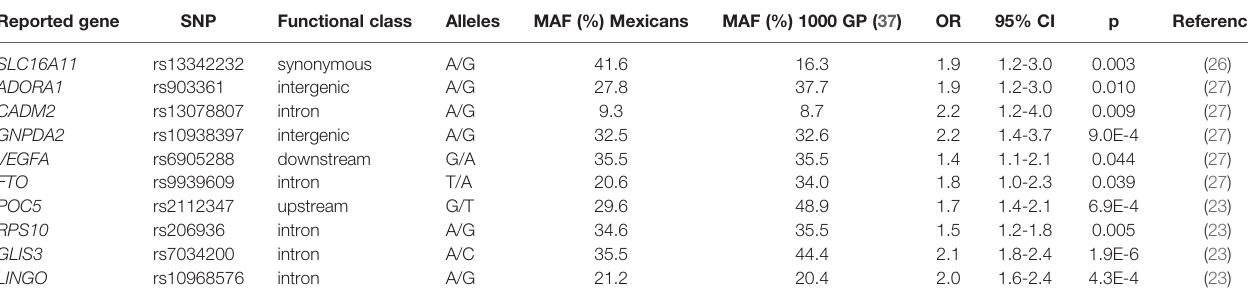
TABLE 1 | List of the 10 single nucleotide polymorphism considered in the genetic risk score computation. Reported